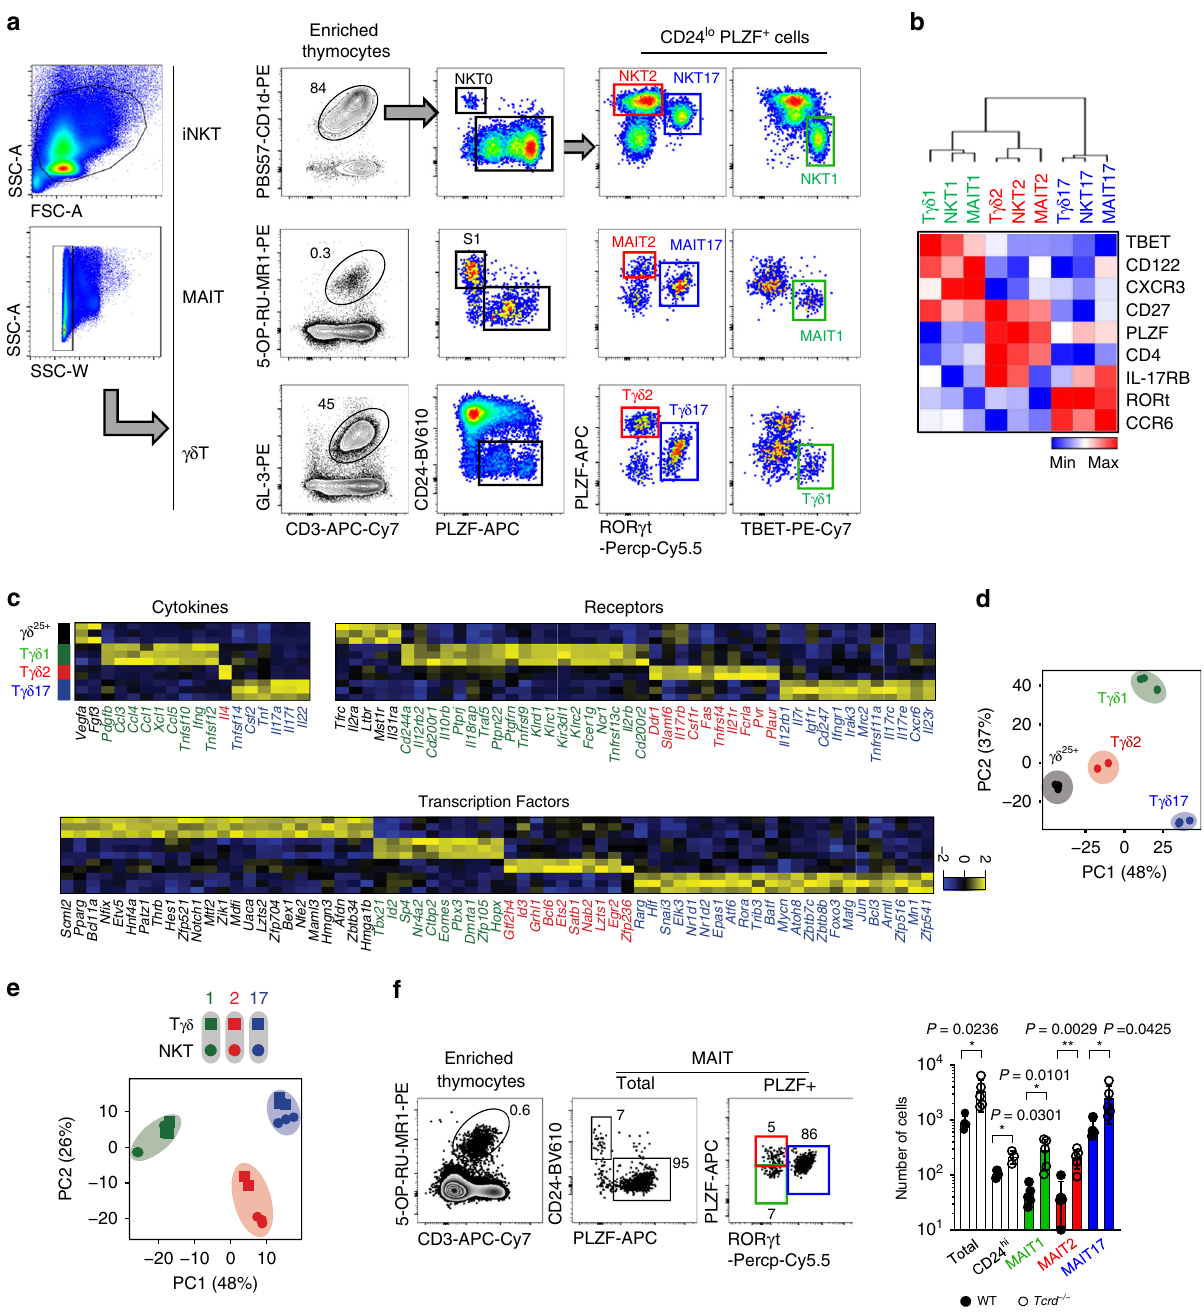
Fig. 1 Innate T cells have analogous effector subsets. a Single-cell suspensions of 7-week-old BALB/c thymocytes were stained with PBS57 loaded CD1d tetramer, 5-OP-RU loaded MR1 tetramer, and anti-TCR γδ (GL3), and enriched for iNKT, MAIT, and γδ T cells respectively using MACS beads. Representative dot plots are shown and numbers indicate frequencies of cells in adjacent gates. Representative results of at least 10 independent experiments are shown. b Heat map shows log 2 values of mean fl uorescence intensities of cells expressing indicated markers analyzed by fl ow cytometry. Hierarchical clustering was made by Pearson correlation. Representative results of three independent experiments are shown. c Heat maps show expression patterns of cytokines, receptors, and transcription factors mapped to overexpressed genes in each T γδ subset. Expression patterns were quanti fi ed by column Z -scores of regularized log 2 -value of read counts. d Principal component analysis (PCA) plot shows subset distribution of T γδ subsets. Each dot represents a biological replicate. e PCA plot using 120 functional genes including cytokines, receptors, and transcription factors shows subset distribution of iNKT and γδ T cells. Each dot represents a biological replicate. f MAIT cells were enriched from Tcrd KO mice and analyzed for their subset pro fi les. Graph shows statistical analysis of number of MAIT subsets in indicated mice ( n = 5 except analysis for CD24 hi stage 1 MAIT cells ( n = 3), right). Results are pooled from three independent experiment and numbers indicate frequencies of cells in adjacent gates (left). Each dot represents an individual mouse. Data are presented as mean ± SD. Unpaired two-tailed t -test was used. * P < 0.05, ** P < 0.01. Source data are provided as a Source Data fi